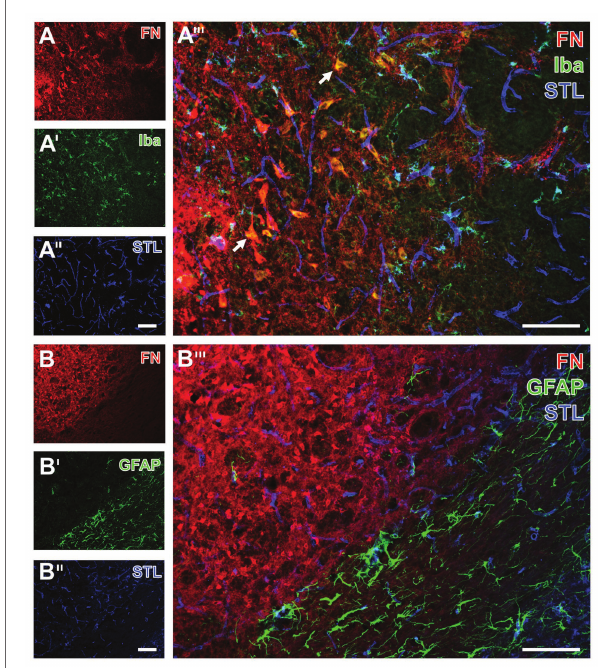
FIGURE 7 | Immunofluorescence-based visualization of fibronectin together with vasculature elements and neurons in rats subjected to 24 h of experimental focal cerebral ischemia. Detection of fibronectin (FN, A ) in conjunction with collagen IV (Coll IV, A ' ) and neurons using NeuN (B ' ) as well as the vasculature as visualized by a lectin-based technique using LEA (A '' ) and STL (B '' ) in the ischemia-affected striatum confirms concomitantly increased immunosignals of FN and Coll IV (A ''' ) also in the rat, and neuronal degeneration due to ischemia by an altered NeuN staining in the affected area (B ''' ) . Both LEA and STL robustly visualize vessels also in ischemic areas, although STL leads to a somewhat thinner appearance of vessels in ischemic regions (B ''' ) . Scale bars: in A ''' and B ''' = 100 μ m, in A '' (also valid for A and A ' ) and B '' (also valid for B and B ' ) = 100 μ m.